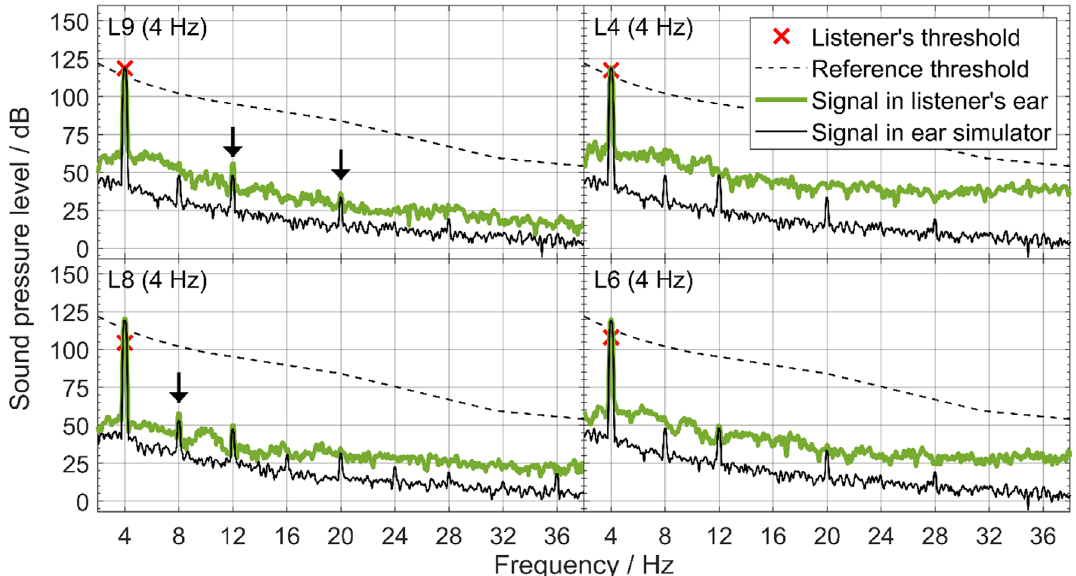
Figure 4. Magnitude spectra for a 4 Hz infrasound, measured with the low-noise ER-10B+ microphone, in the ear canal of four listeners (green solid lines) and the corresponding spectra in the B&K 4157 occluded-ear simulator (black solid lines). Each panel shows the result of one listener. In all panels, the spectra are limited to the frequency range from 2 Hz to 38 Hz. The reference thresholds are shown as a black dashed line, the individual thresholds as red crosses. Black arrows indicate ear-generated distortion products, which were identi fi ed by means of criteria described in the text (see also Fig.